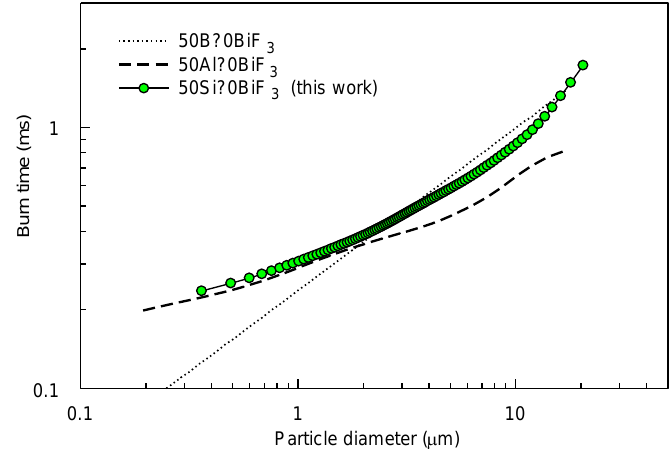
Figure 15. Burn time–particle size correlation for 50Si · 50BiF 3 powder ignited in air by a laser. For comparison, similar correlations are shown for powders of 50Al · 50BiF 3 [20] and 50B · 50BiF 3 [23] obtained by arrested reactive milling.